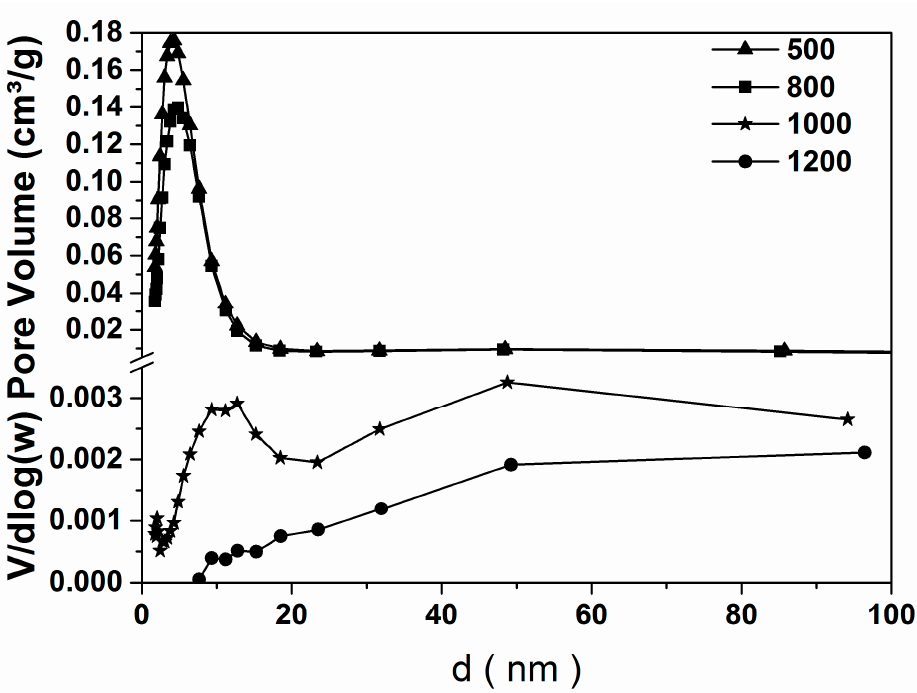
Figure 9. Size distribution of meso- and macro-pores of studied gel samples.